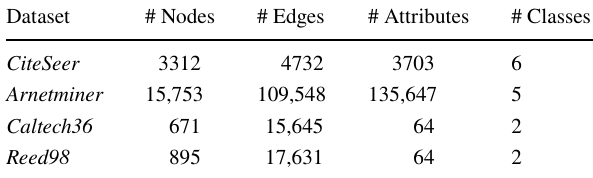
Table 1 Statistics of four real-world datasets